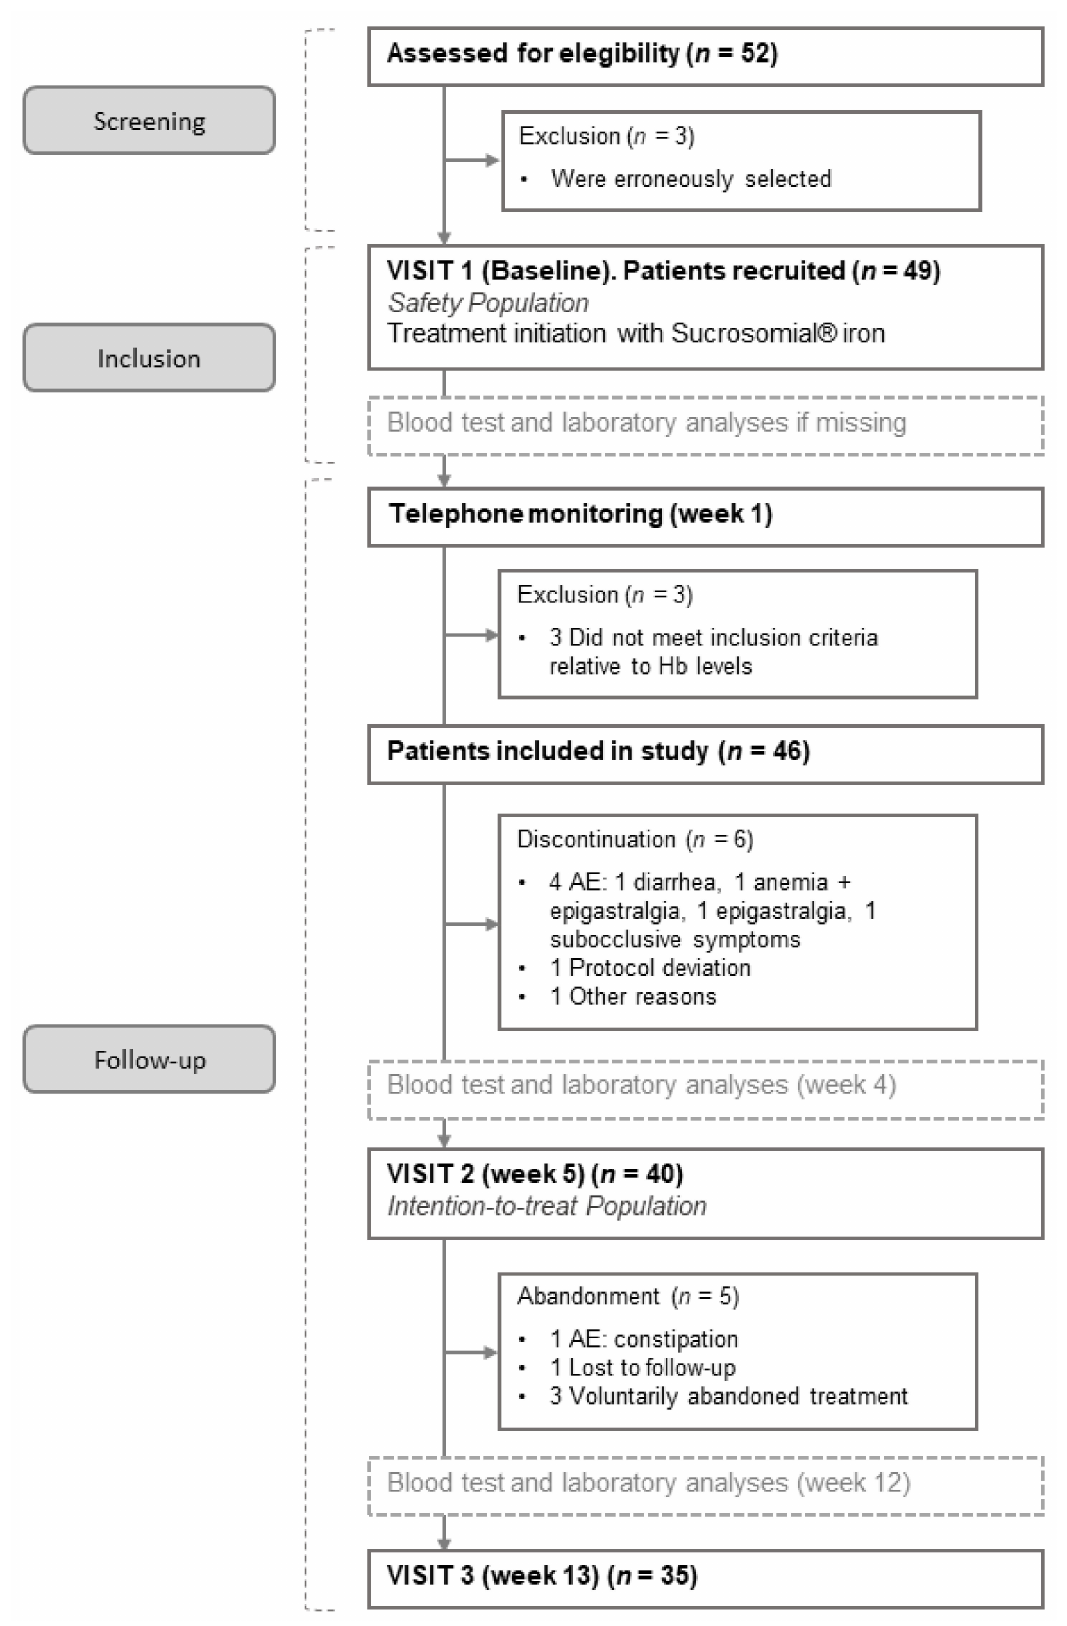
Figure 2. Flow diagram of patient selection for the study. AE: adverse event; Hb: